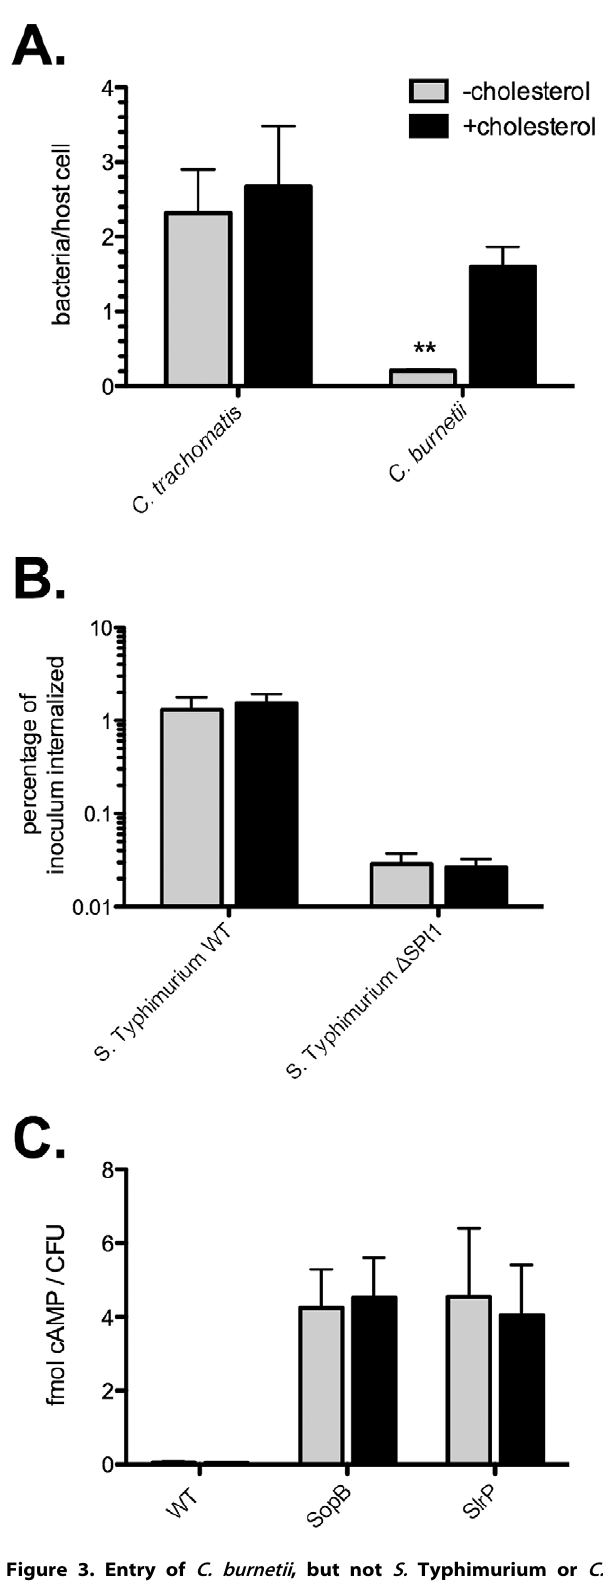
Figure 3. Entry of C. burnetii , but not S. Typhimurium or C. trachomatis , is reduced in the absence of cholesterol. Entry assays were performed to test the ability of C. trachomatis , C. burnetii , and S. Typhimurium to enter host cells in the absence of cholesterol. (A). The number of internalized C. trachomatis was unchanged between 2 cholesterol and + cholesterol MEFs. In contrast, internalization of